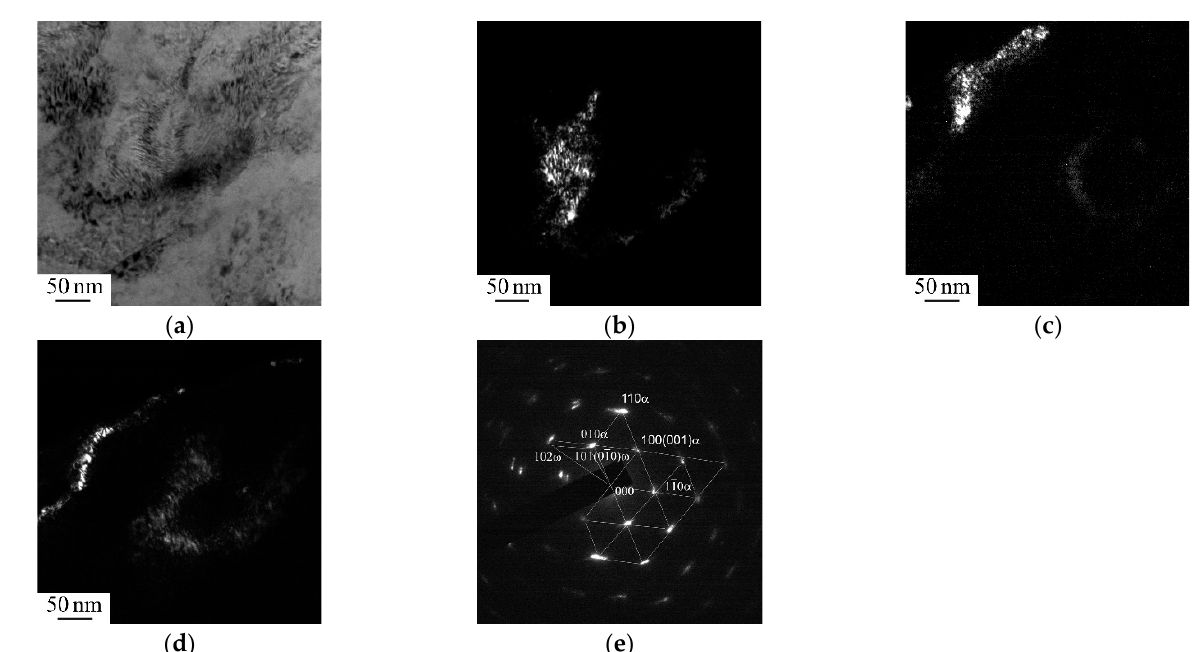
Figure 3. TEM bright- ( a ) and dark-field ( b – d ) images and associated SAED pattern ( e ) of the microstructure of the uppermost surface layer of the CP-Ti sample after the UIT processing. The dark-field images were obtained with the 110(001) α -Ti reflection ( b ), the closely spaced 120 (001) α -Ti and 102 010 ω -Ti ones ( c ), as well as in the 101 ω -Ti reflex ( d ).